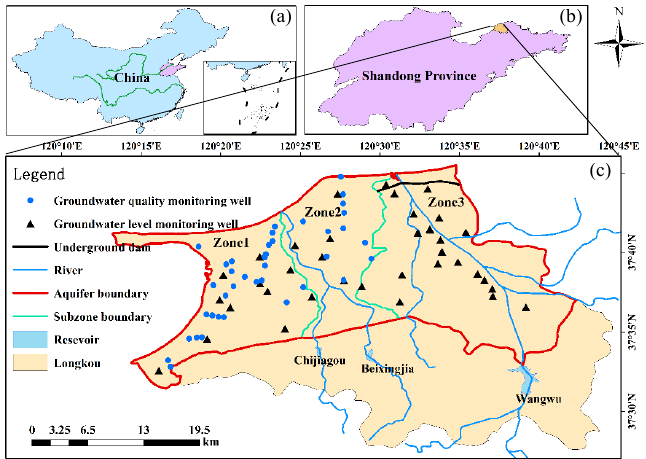
Figure 1. ( a ) Location of Shandong Province in China; ( b ) location of Longkou in Shandong Province; ( c ) description of the study area.